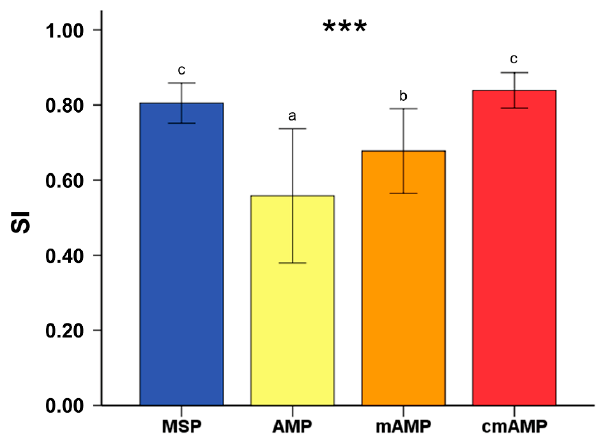
Figure 4. Comparison of the similarity index (SI) between the facial midsagittal plane (MSP) 1 year after surgery and each mandibular midsagittal plane before surgery. MSP, facial midsagittal plane; AMP, absolute mandibular midsagittal plane; mAMP, modified absolute mandibular midsagittal plane; cmAMP, computed modified absolute mandibular midsagittal plane. The p values were calculated using one-way ANOVA. Different letters indicate significant differences between groups. *** p < 0.001.